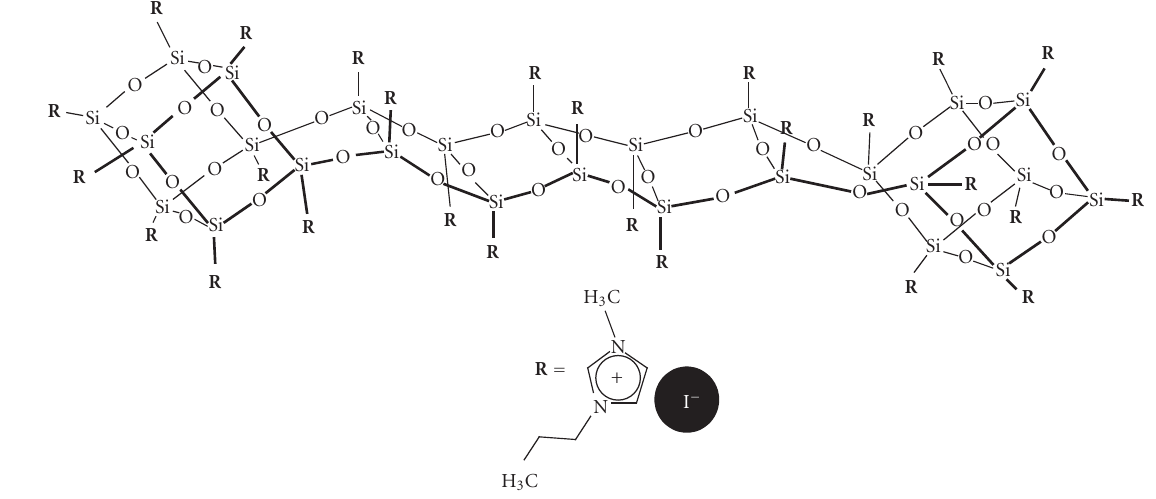
Figure 5: Probable structure of the positively charged polysilsesquioxane species constituting heat-treated (200 ◦ C) hydrolyzed MTMSPI + I − .